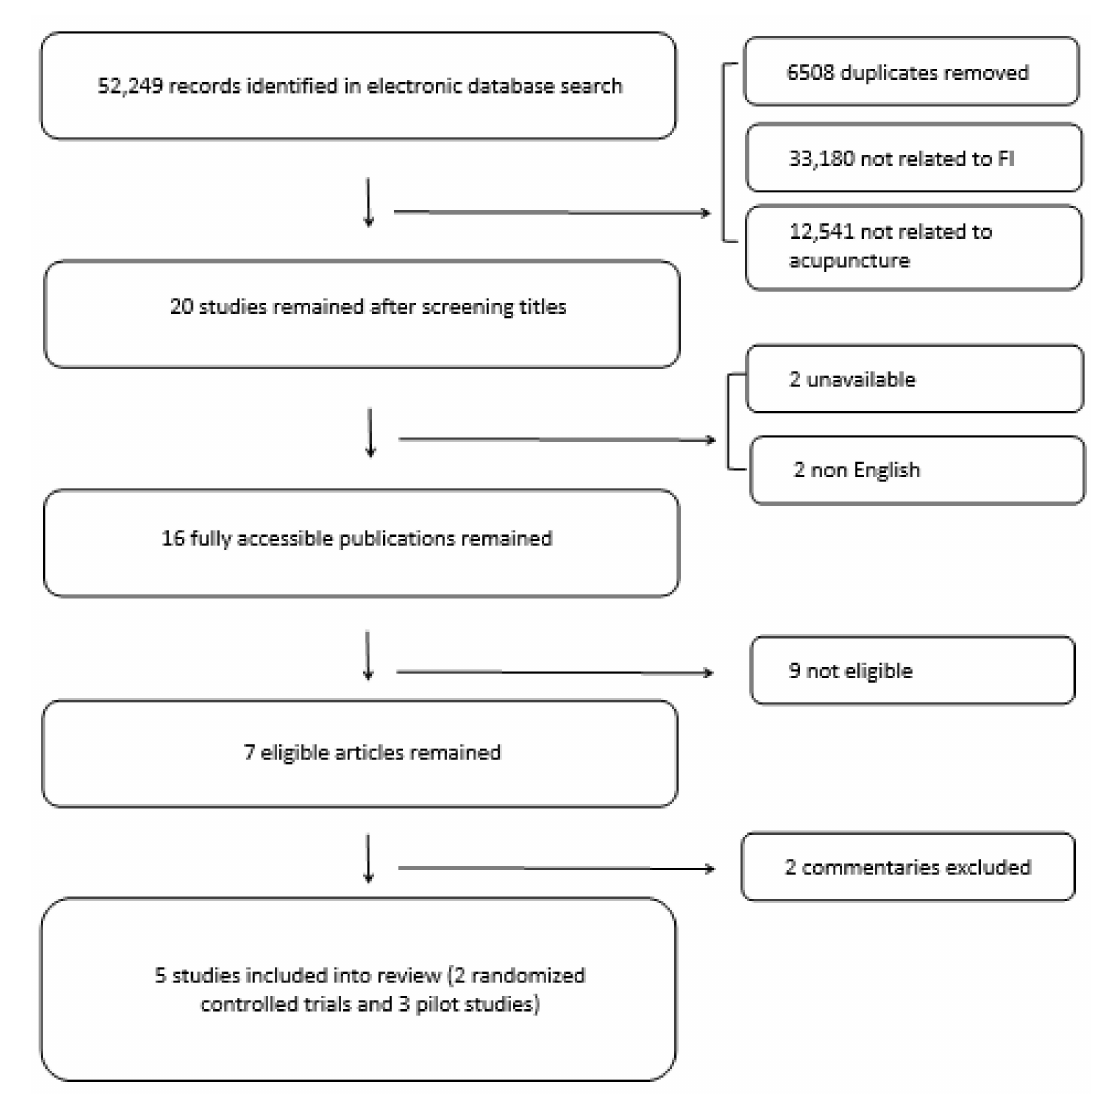
Figure 1. Flow chart of studies